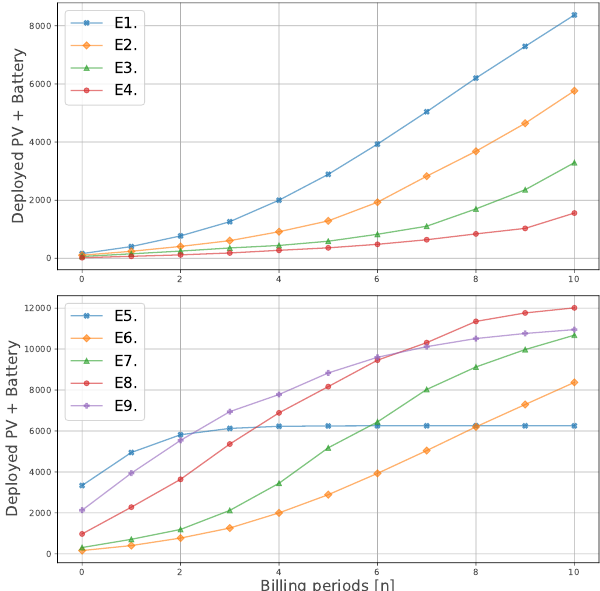
Figure 4. Cumulative sum of the size of the deployed DER installations (including PV and batteries), over the discrete time dynamical system. The upper figure corresponds to the evaluation of tariff designs, whereas the lower one corresponds to the evaluation of the incentive